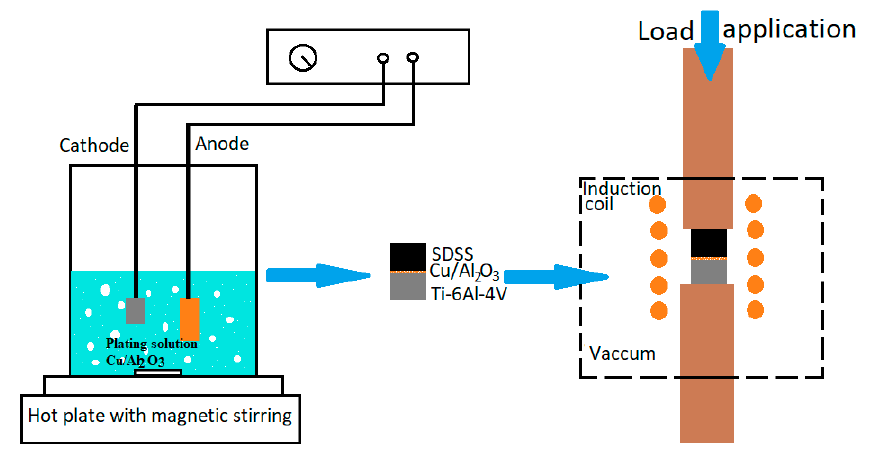
Figure 2. Schematic of the coating deposition and bonding process.